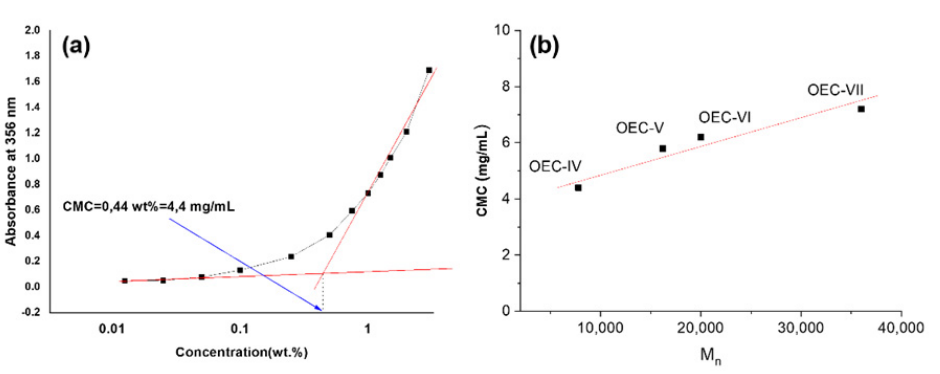
Figure 3. Absorption intensity at 356 nm and CMC determination of OEC-IV ( a ) and CMC versus molar mass of the investigated PEGylated tert -octylcalix[8]arenes in aqueous solution ( b